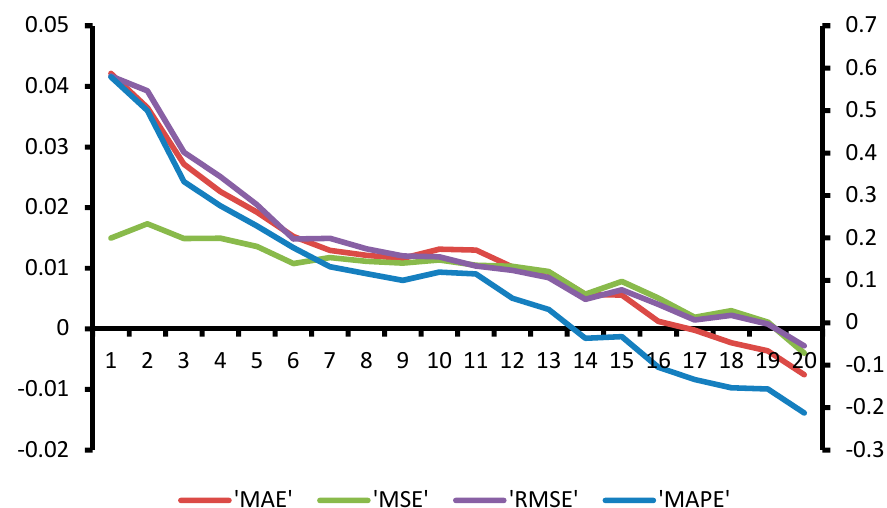
Figure 5. Di ff erential errors between predictions when using prices of CO 2 emission allowances only and when fluctuations of electricity and of iron and steel prices are also used as input variables. Table 7. Prediction errors of CO 2 emission allowance prices when electricity trends or iron and steel trends are also used as input